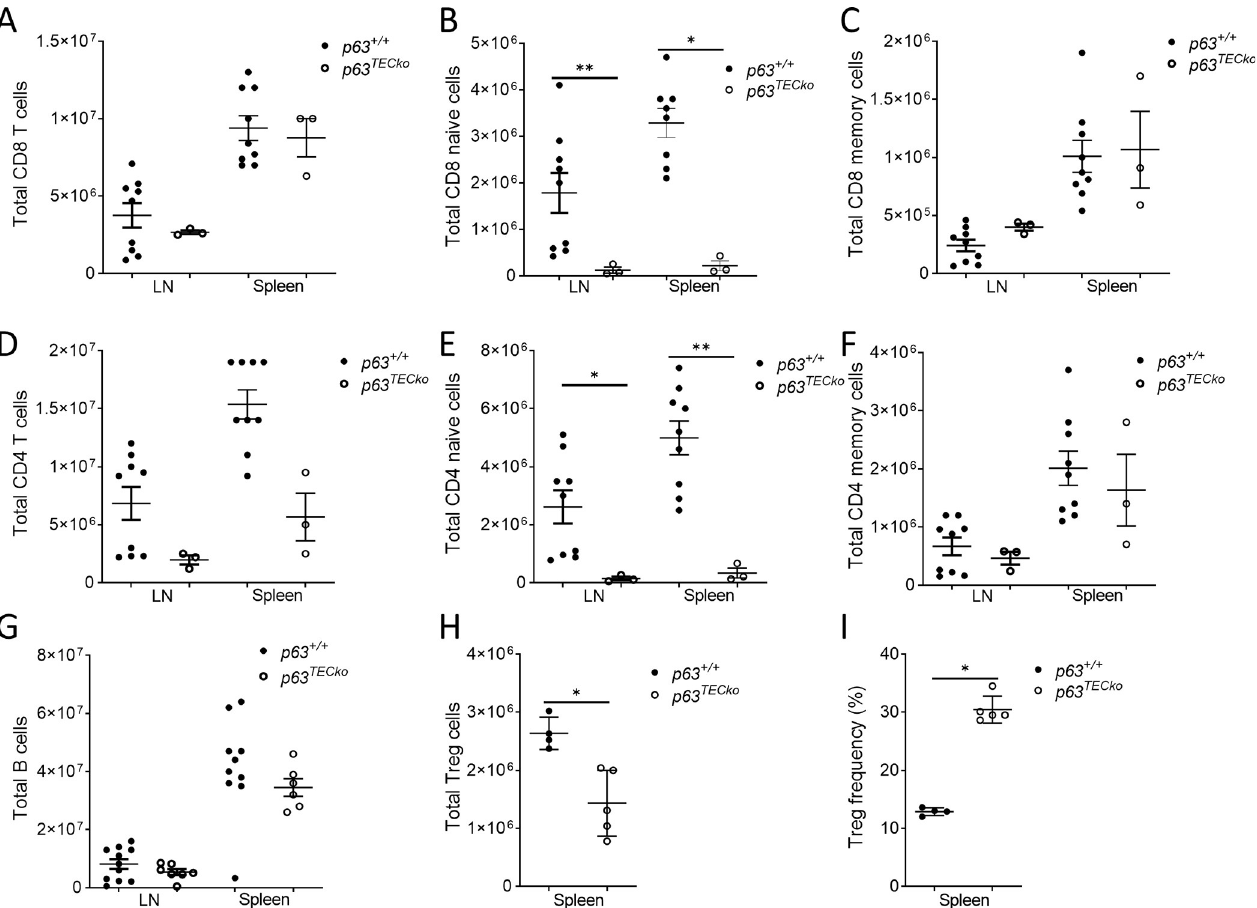
Fig 4. The peripheral T cell compartment shows decreased na ï ve cells in p63 TECko mice. Flow cytometric analysis for the cell-surface expression of CD4 and CD8 splenocytes and lymphocytes were isolated p63 TECko and littermate controls. Regulatory T cells were defined as CD4 + CD25 bright and FoxP3 + . Numbers denote absolute number of cells. (Total CD8 (4A), CD8 naive (4B; LN, p = 0.0573; spleen, p = 0.0003), CD8 memory (4C), total CD4(4D; spleen, p = 0.0031), CD4 naive (4E; LN, p = .0370; spleen, p = 0.0013), CD4 memory (4F), B cells (4G), Treg (4H, p = 0.0159) and frequency of Treg (4I, p = 0.0159). This experiment was done at least twice with at least three mice per group. P values are